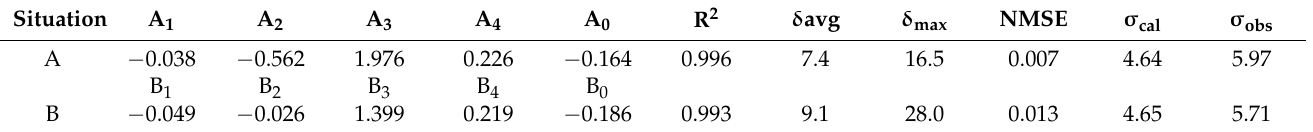
Table 2. The coefficients and constants, coefficient of determination (R 2 ), average and maximum of the absolute relative bias ( δ avg, δ max (%)), normalized mean square error (NMSE) and standard deviations of calculated and observed fluxes ( σ cal and σ obs ) for the O 3 empirical model considering isoprene and monoterpene roles (situation A and B), respectively. Situation A 1 − 0.038 −